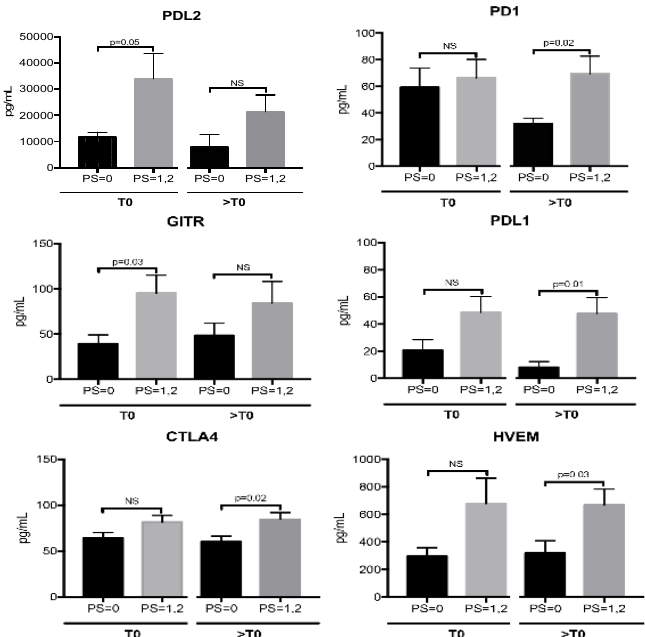
Figure 3. Levels of soluble immune check point ‐ related molecules evaluated in NSCLC patients scored as performance status (PS) = 0 and PS = 1,2 before the beginning of nivolumab treatment (T0) and at first clinical evaluation (>T0). Histograms represent the concentration mean values of sICs ± SEM detected in the serum of patients with PS = 0 (9 patients) (black histograms) and PS = 1,2 (13 patients) (grey histograms) by Luminex multiple assay. The median values of sICs ± SEM at T0 are as follows: PDL2: PS = 0 vs. PS1,2, 12 ± 2 vs. 34 ± 10 ng/mL; GITR: PS = 0 vs. PS1,2, 39 ± 10 vs. 95 ± 20 pg/mL; CTLA4: PS = 0 vs. PS1,2, 64 ± 6 vs. 81 ± 7 pg/mL; PD1 PS = 0 vs. PS1,2, 59 ± 14 vs. 71 ± 14 pg/mL; PDL1: PS = 0 vs. PS1,2, 21 ± 7,5 vs. 49 ± 12 pg/mL; HVEM: PS = 0 vs. PS1,2, 296 ± 62 vs. 677 ± 185 pg/mL. At >T0, the mean values of sICs ± SEM are: PDL2: PS = 0 vs. PS1,2, 8 ± 1,5 vs. 21 ± 7 ng/mL; GITR: PS = 0 vs. PS1,2, 48 ± 13 vs. 84 ± 23 pg/mL; CTLA4: PS = 0 vs. PS1,2, 60 ± 6 vs. 84 ± 7.3 pg/mL; PD1 PS = 0 vs. PS1,2, 32 ± 4 vs. 69 ± 13 pg/mL; PDL1: PS = 0 vs. PS1,2, 8 ± 4 vs. 48 ± 12 pg/mL; HVEM: PS = 0 vs. PS1,2, 319 ± 90 vs. 668 ± 115 pg/mL. A Student’s unpaired t ‐ test was used to compare the differences of sIC levels between patients with PS = 0 and PS = 1,2 evaluated at T0 and at >T0. p values ≤ 0.05 were considered significant.